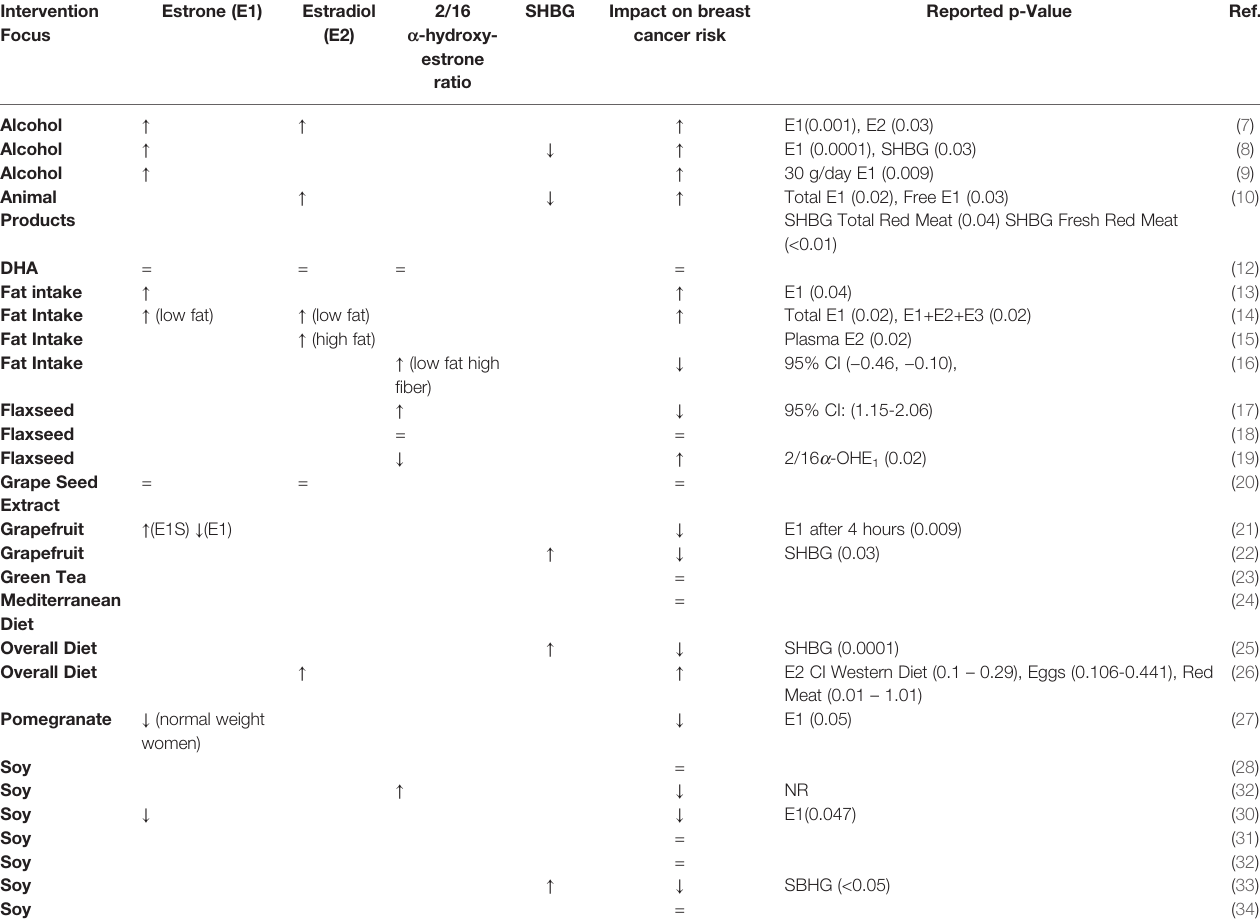
NR, not reported. “ ↑ ” , “ ↓ ” and “ = ” stand for "increased" , "decreased" and "no change".